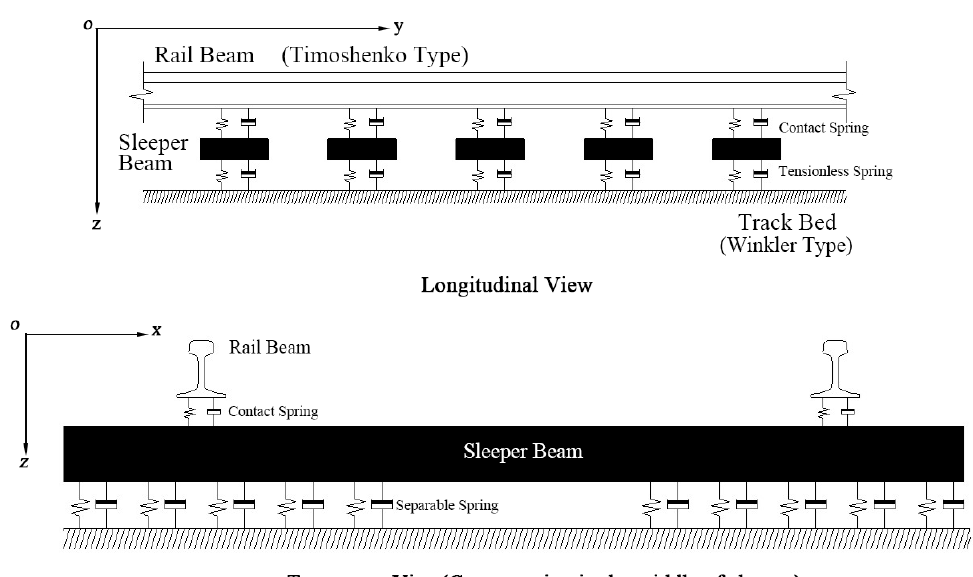
Figure 4. 1:4 Idealized rail track model.